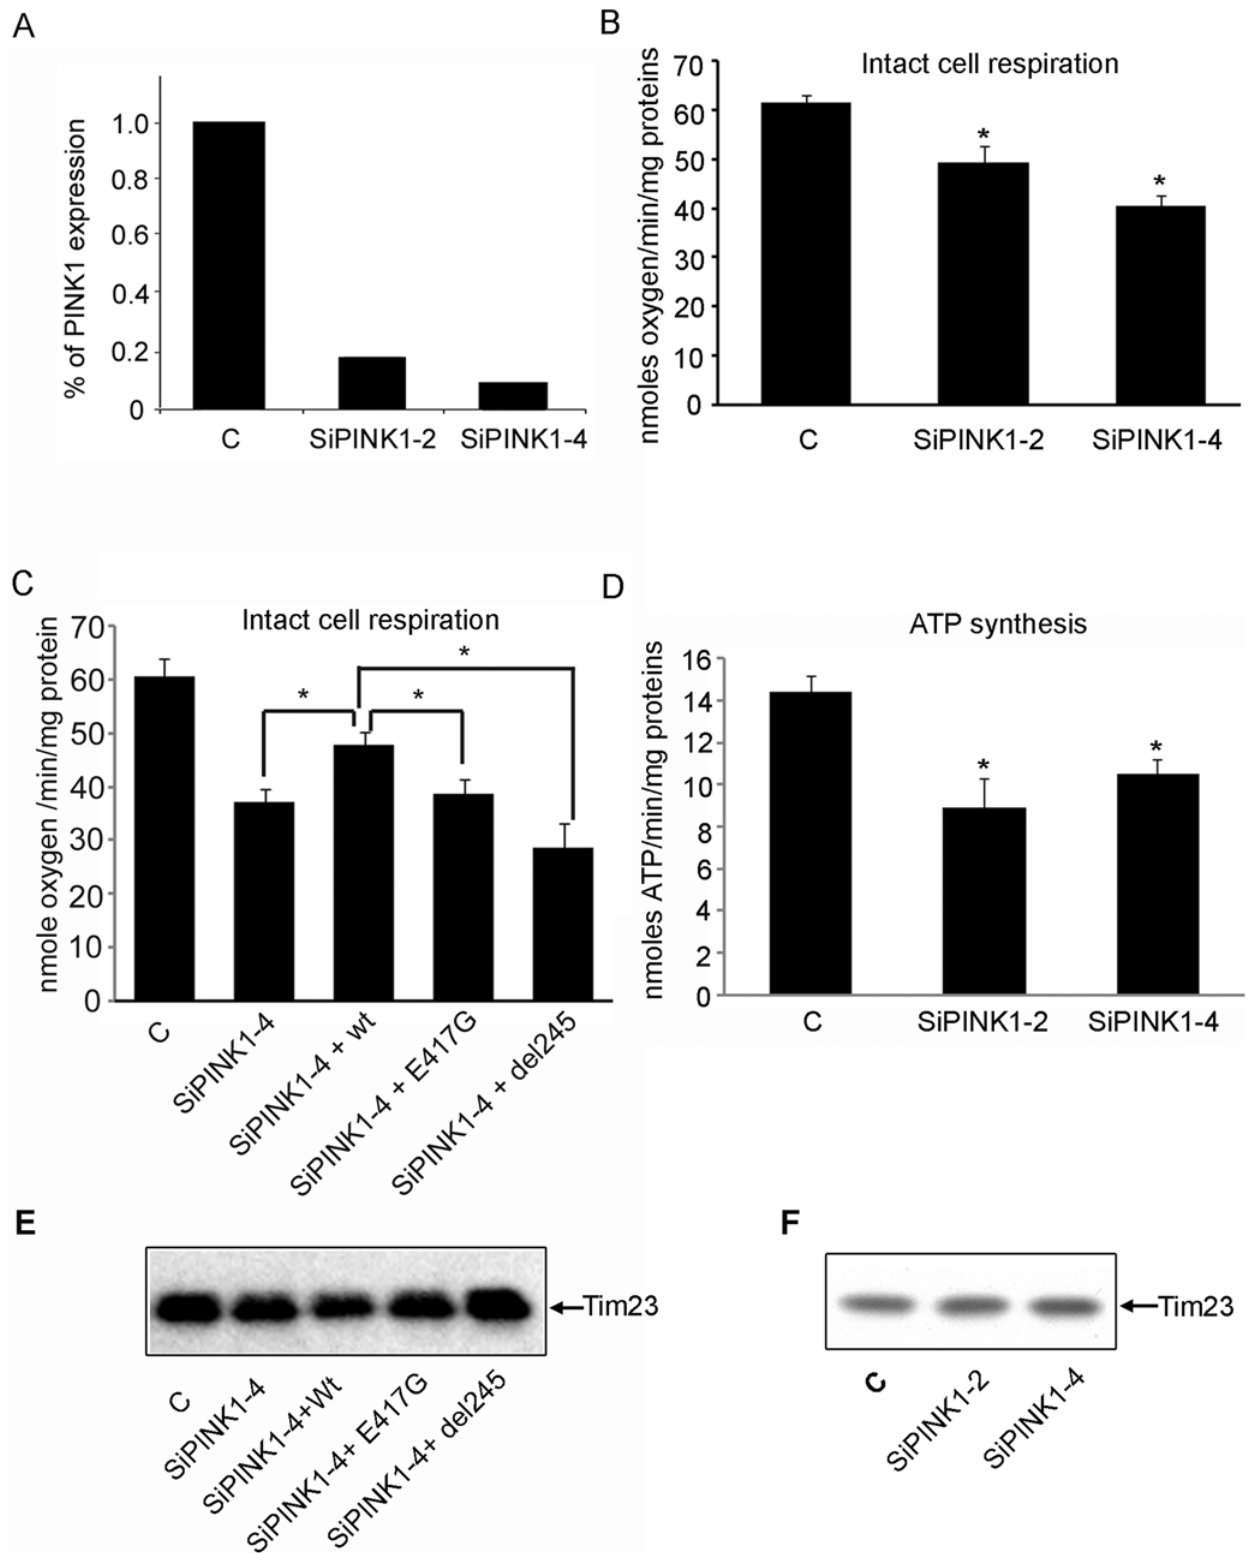
Figure 6. Loss of PINK1 impairs OXPHOS function in PC12 cells with reduced PINK1 expression. Normal respiration is impaired in the PC12 cell lines with PINK1 knocked-down by RNAi. A) PINK1 mRNA is significantly reduced in two stable cell lines expressing PINK1 siRNA. Compared to the wild type control, there is an 81.7% and 91% reduction in PINK1 mRNA in SiPINK1-2 and SiPINK1-4 cell line. The level of PINK1 mRNA is normalized to GAPDH. B) Oxygen consumption is significantly